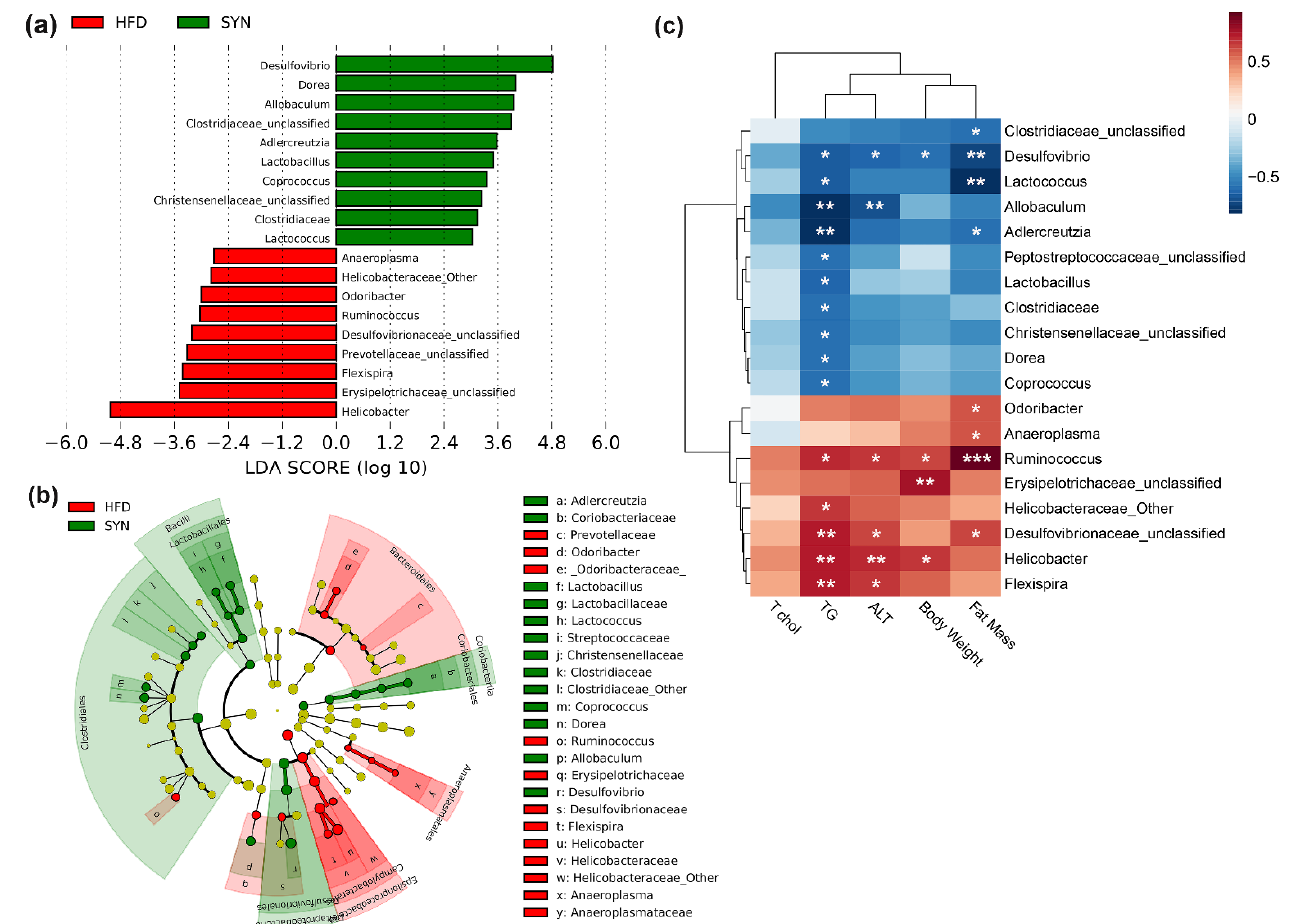
Figure 4. Association between gut microbiota and metabolic parameters. ( a ) Linear discriminant analysis effect size (LEfSe) histogram showing significant differential taxa between HFD (red) and SYN (green) groups, and ( b ) cladogram plot from LEfSe showing the phylogenetic relationships among differential taxa in HFD (red) and SYN (green) groups. ( c ) Heatmap based on Spearman’s correlation between gut microbiota and obesity-associated metabolic parameters. The significance values [ p < 0.05], [ p < 0.01], and [ p < 0.001] is denoted as *, **, and ***, respectively. HFD: high-fat diet; SYN: high-fat diet + L. rhamnosus 4B15 + C. tricuspidata .